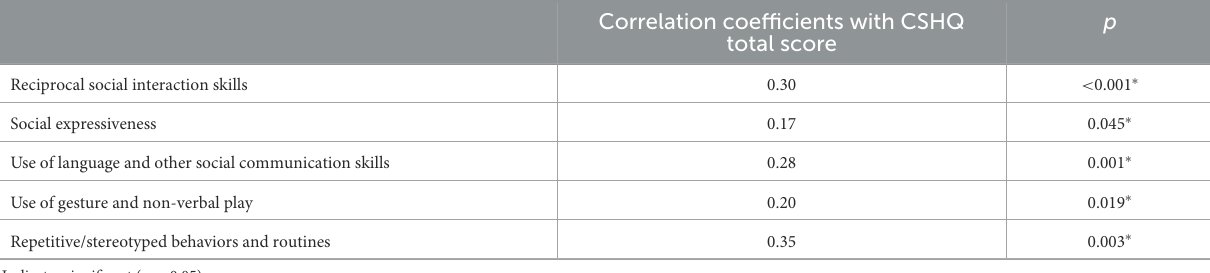
TABLE 3 Spearman’s correlation coefficients between 3di subcategory scores and CSHQ total scores.